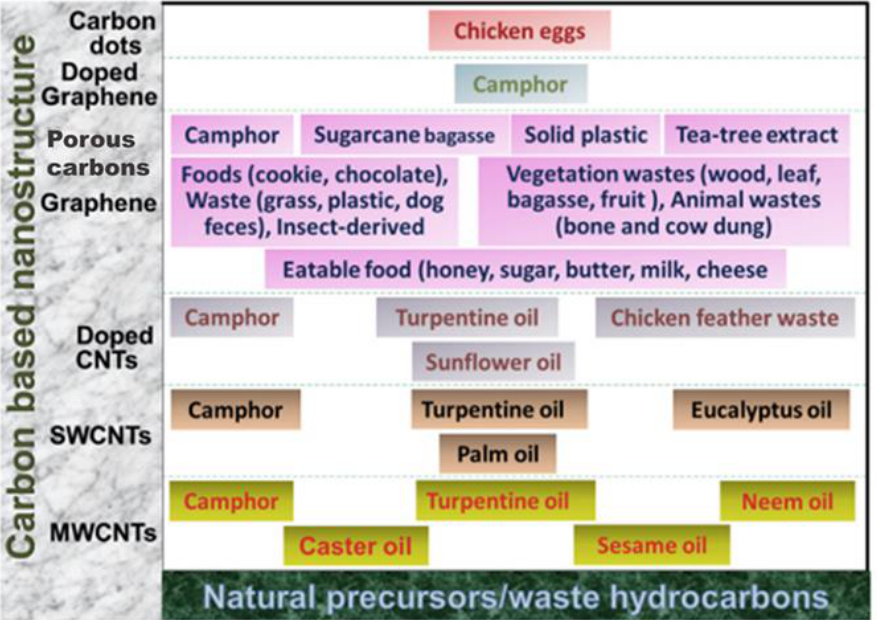
Figure 2. Schematic representation of the natural precursors, eatable food, and waste hydrocarbons used for the synthesis of various carbon-based materials. Adapted with permission from ref. [17].